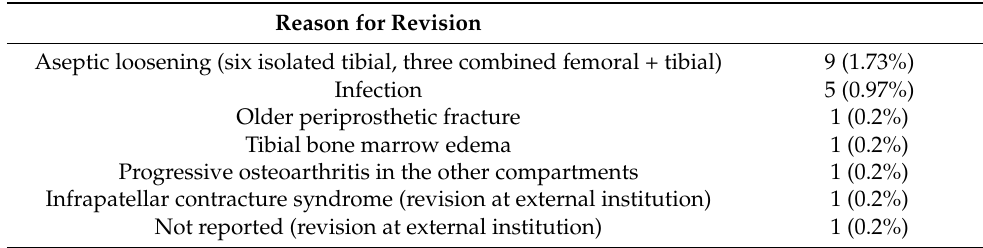
Table 2. Reasons for revisions of the iUni arthroplasty (all medial, no revision of lateral